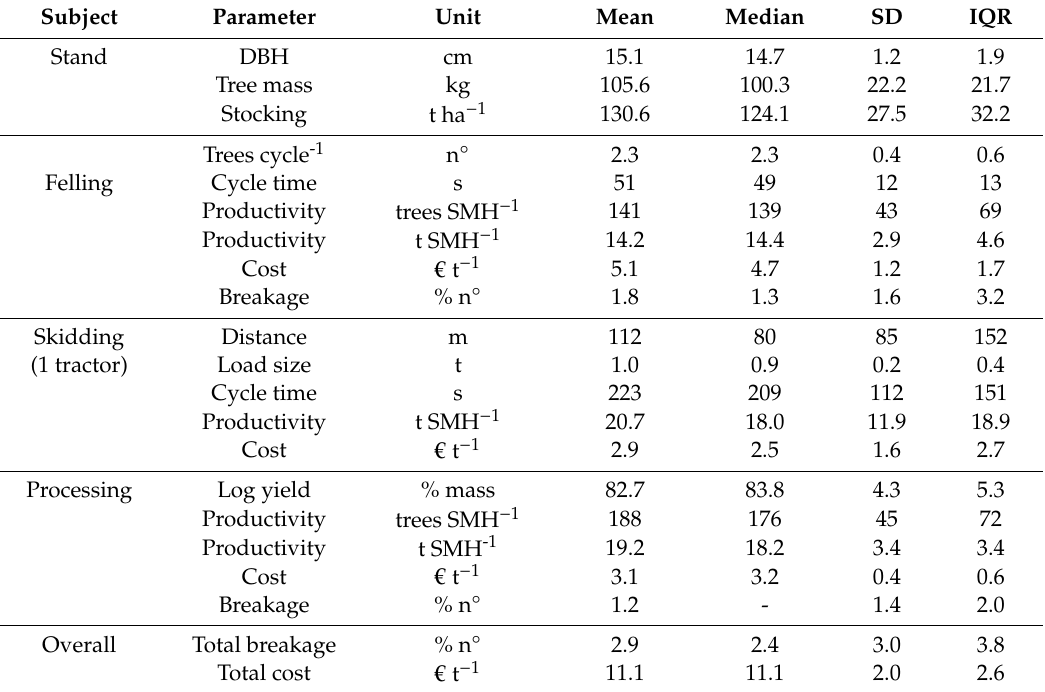
Table 2. Main results of the productivity study.